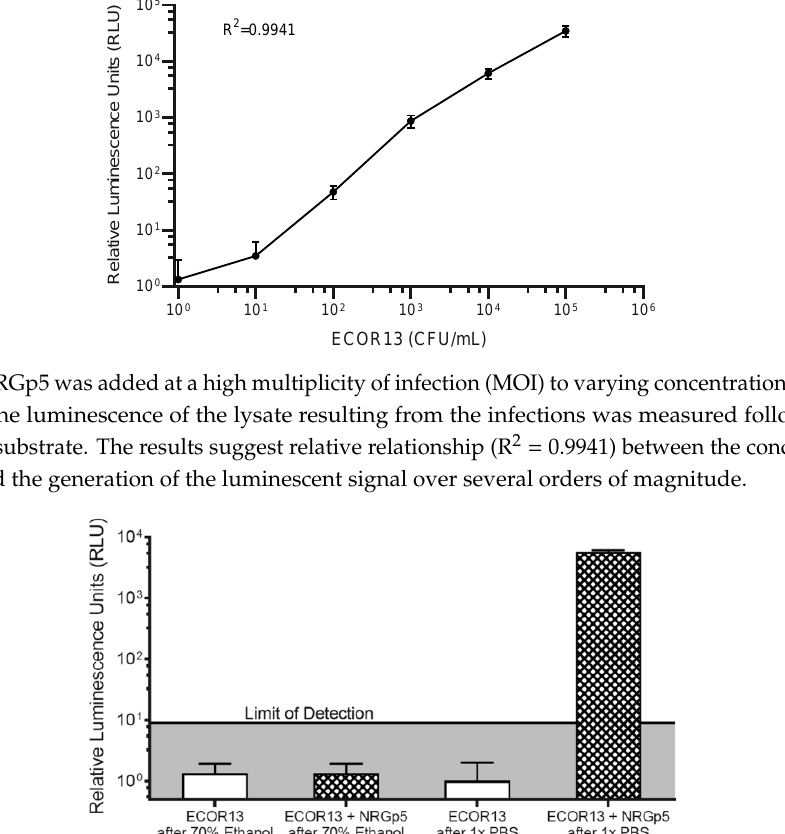
Figure 5. To demonstrate the ability of the phage-based assay to distinguish between viable and non- viable E. coli ECOR13 cells, 10 3 bacterial cells were exposed to either 70% ethanol or PBS, and washed. The cells were then either infected with NRGp5 or incubated without phages. The only cell treatment regime to display luminescence following incubation and substrate addition was the non-ethanol treated E. coli ECOR13 infected with